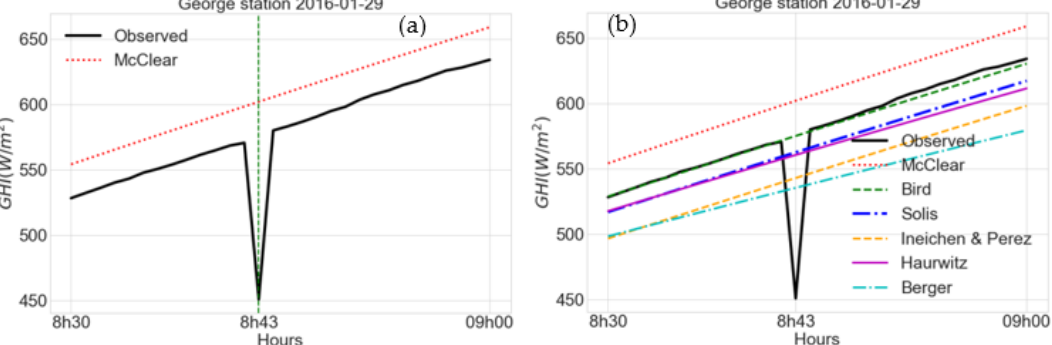
Figure 5. A plot of observed radiation data on 29 January 2016 from 08:30 am to 09:00 am at George station and McClear model on a corresponding period ( a ) and a plot of observed radiation data and 6 clear sky models on the corresponding period ( b ).